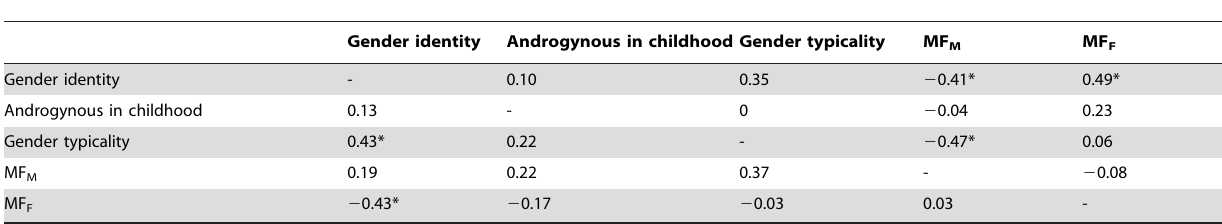
Table 4. Spearman correlations of gender perception measures in autism spectrum